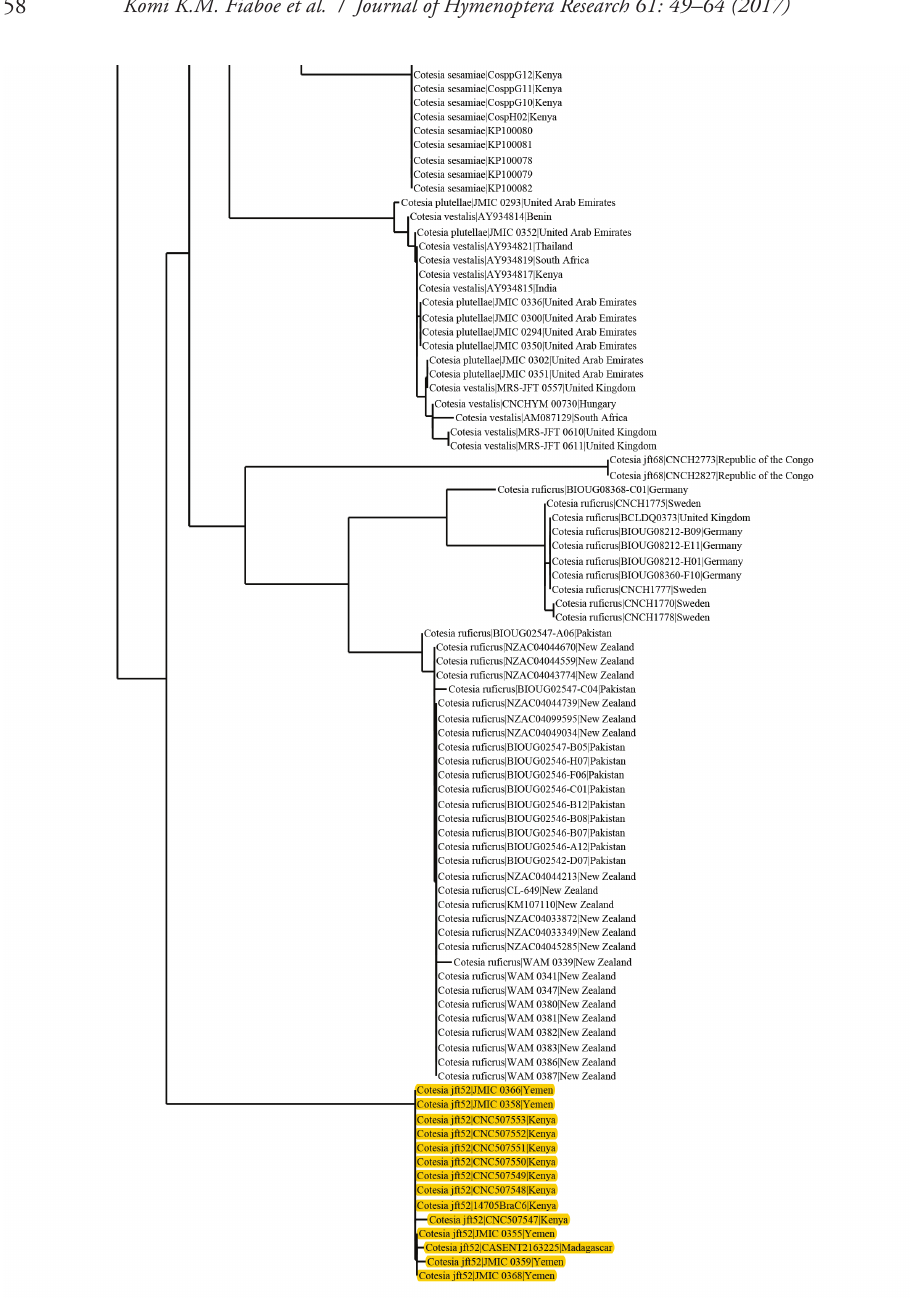
Figure 5. Continued. Neighbor-joining tree (K2P) of Afrotropical species of Cotesia in the Barcoding of Life Data System (BOLD) with over 500 base pairs; data accessed on September 2017. Specimens named as “ Cotesia jft52” in BOLD actually belong to the species Cotesia icipe (cluster highlighted in Yellow), and specimens named as “ Cotesia jft68” in BOLD actually belong to the species Cotesia chrysippi (Viereck,